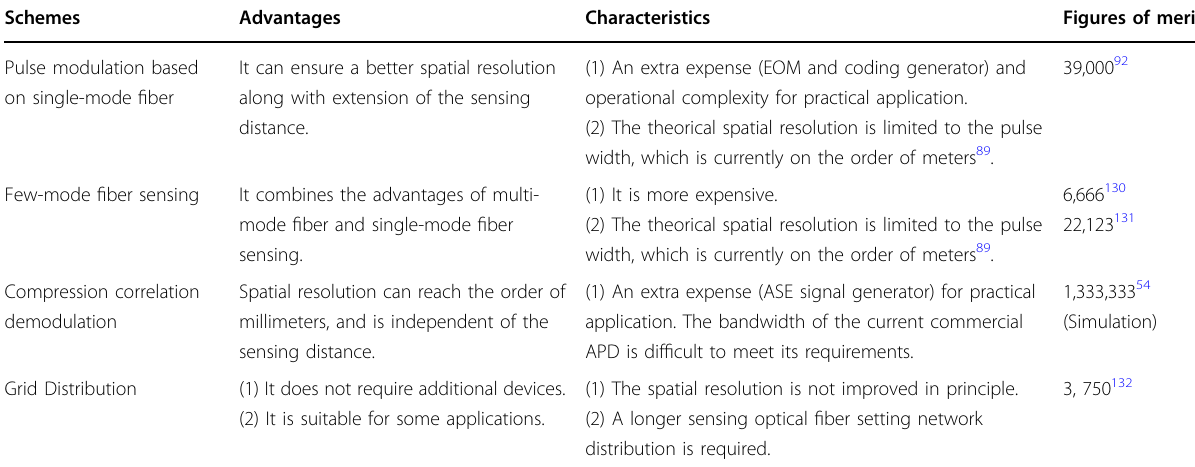
Table 9 Advantages and characteristics of different schemes for simultaneous improvement of sensing distance and spatial resolution